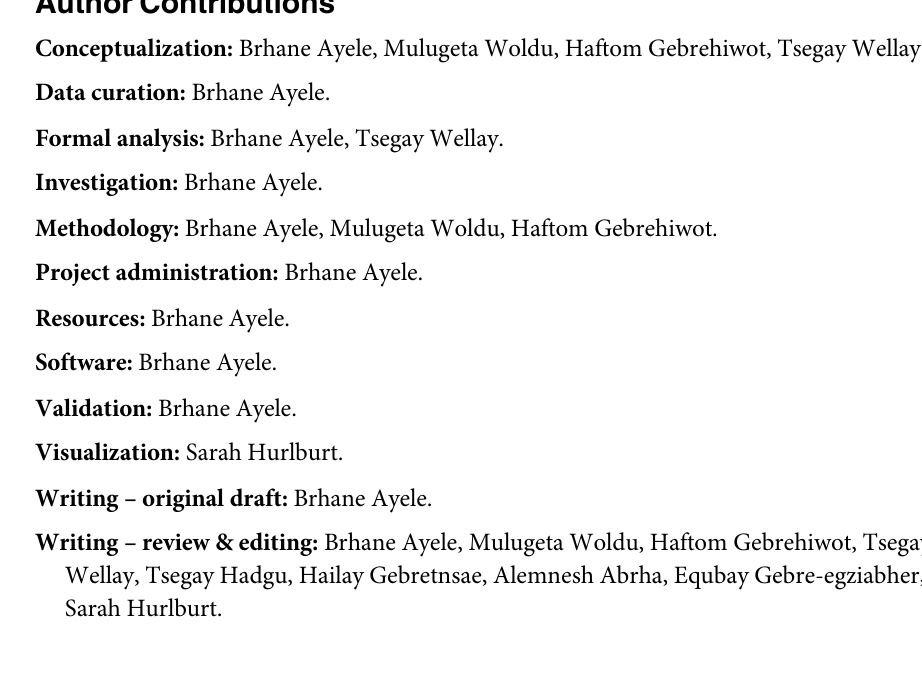
S1 Fig. Schematic presentation of sampling procedure. S2 Fig. Magnitude of women who returned to health facility for PNC use after they